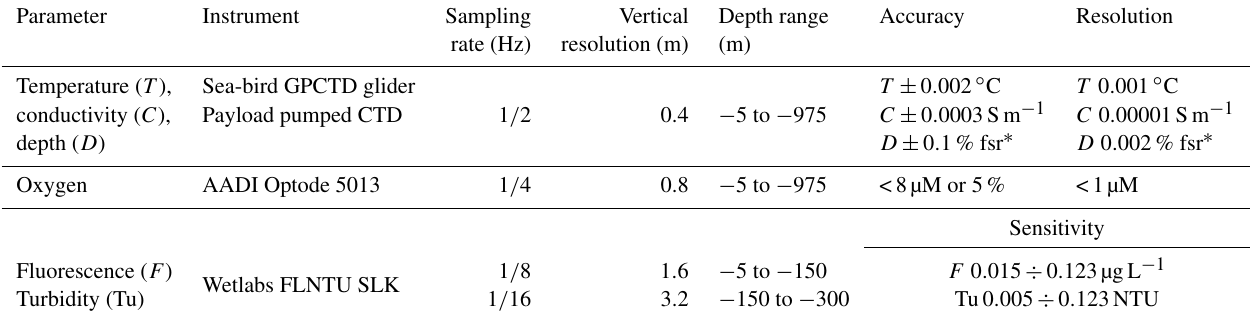
Table 1. Sampling rate and vertical resolution of ABACUS gliders’ data (adapted from Cotroneo et al., 2016; Aulicino et al., 2018). Parameter